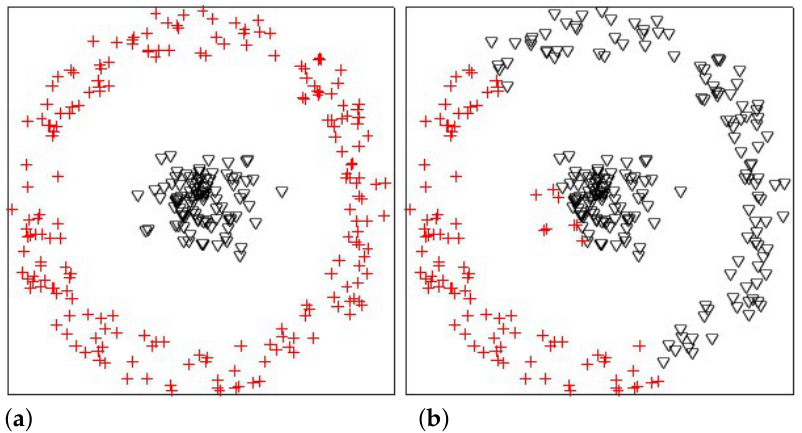
Figure 3. The results of the synthetic dataset clustered by Gaussian radial basis function kernel probabilistic k-means (KPKM) ( a ) and linear KPKM ( b